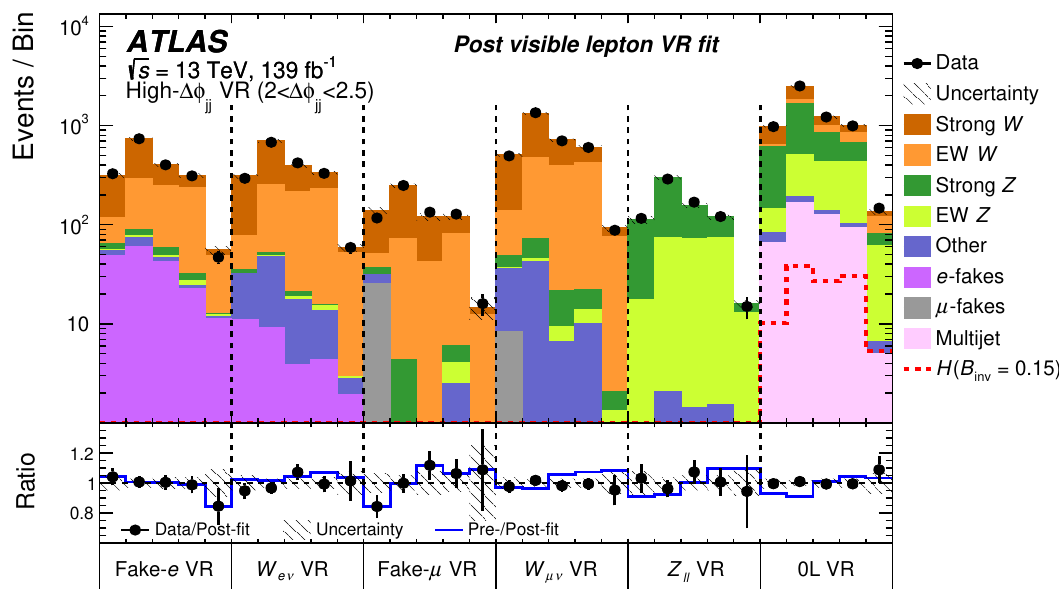
Figure 10. Post-fit yields and their uncertainties for all VR bins with 2 < ∆ φ jj < 2 . 5 and with µ set to zero. The five bins in each region correspond to the m bins of the SR bins 1–5 and 6–10. jj The fit is performed only in the VR bins with one or two leptons, and the fitted background scaling factors β are applied to the corresponding VR bins with zero leptons. Minor contributions from t ¯ t , i V V , V V V , and VBF H with H → τ + τ − or H → W ∗ W are combined and labelled ‘other’. The resulting background expectations are compared with the observed yield. The signal is scaled to a branching ratio of 15% for Higgs boson decays into invisible particles. The ratio of the observed yields to the prediction of the model post-fit is shown by the points in the bottom plot and the relative change of the prediction with respect to the pre-fit yields is shown by the blue line.